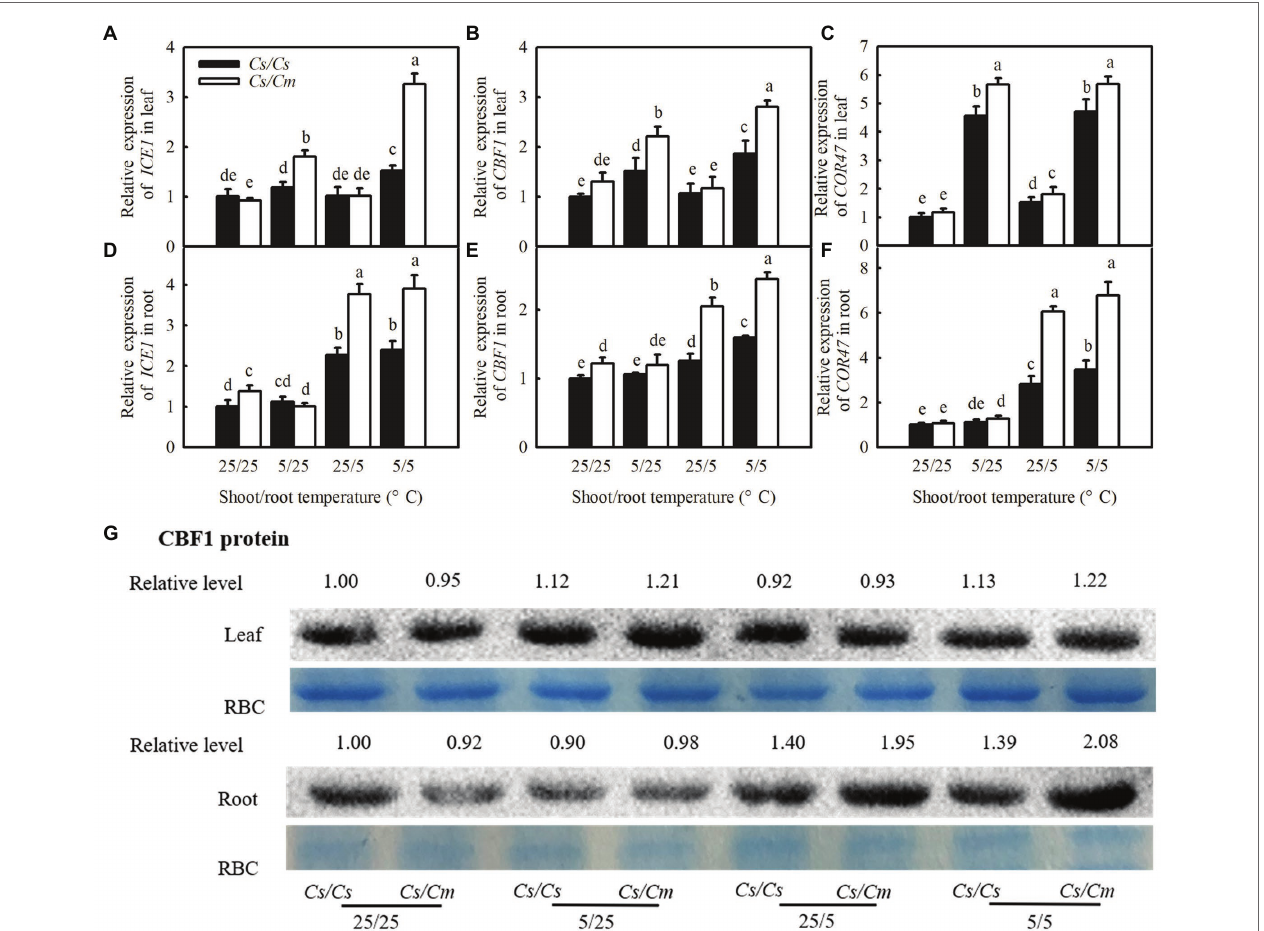
FIGURE 2 | Changes of the relative mRNA expression of C-repeat-binding factor ( CBF1 ), inducer of CBF expression ( ICE1 ), cold-responsive ( COR47 ) genes, and the protein level of CBF1 in the Cs/Cs and Cs/Cm plants under aerial or/and root-zone chilling stress. (A–F) Relative mRNA expression of ICE1 , CBF1 , and COR47 in leaves and roots; (G) the protein level of CBF1 in leaf and root. Three-leaf stage seedlings were exposed to chilling stress for 48 h. Data are the means of four replicates (±SDs). Different letters indicate a significant difference between samples according to Duncan’s new multiple range test ( p <